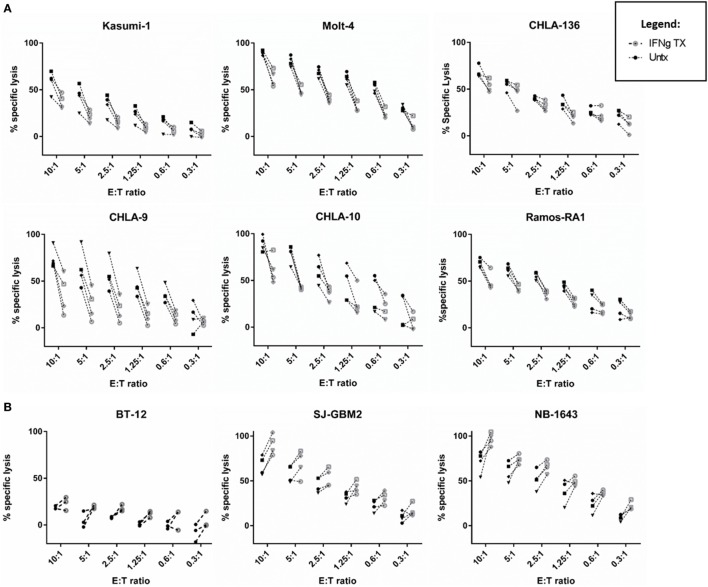
IFNγ has a variable impact on natural killer (NK) cell-mediated cancer lysis. NK cell cytotoxic activity toward IFNγ-treated (gray) and -untreated (black) cancer cells was evaluated at six different effector to target (E:T) ratios using calcein release assays. (A) Cell lines showing decreased lysis [leukemia (Molt-4, Kasumi-1), Ewing sarcoma (CHLA-9, CHLA-10), lymphoma (Ramos-RA1), and neuroblastoma (NB) (CHLA-136)] and (B) cell lines showing increased lysis [brain tumors (BT-12, SJ-GBM2) and NB (NB1643)] after IFNγ treatment. The four NK cell donors are represented for all cell lines, except for BT-12 with three donors represented.